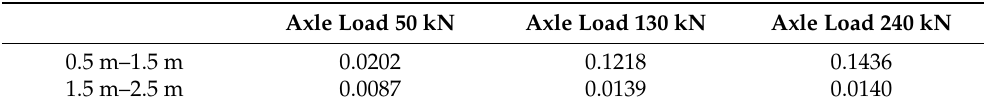
Table 4. Modulus-ratio